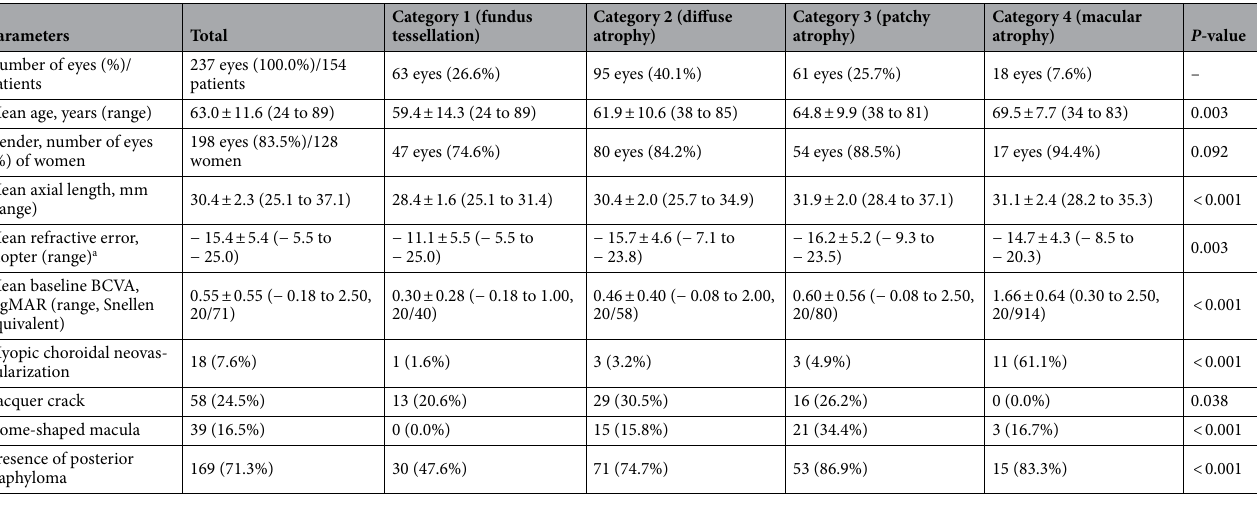
Table 1. Baseline characteristics and demographics of patients. BCVA best-corrected visual acuity, logMAR logarithm of minimal angle of resolution. a Phakic eyes without history of refractive